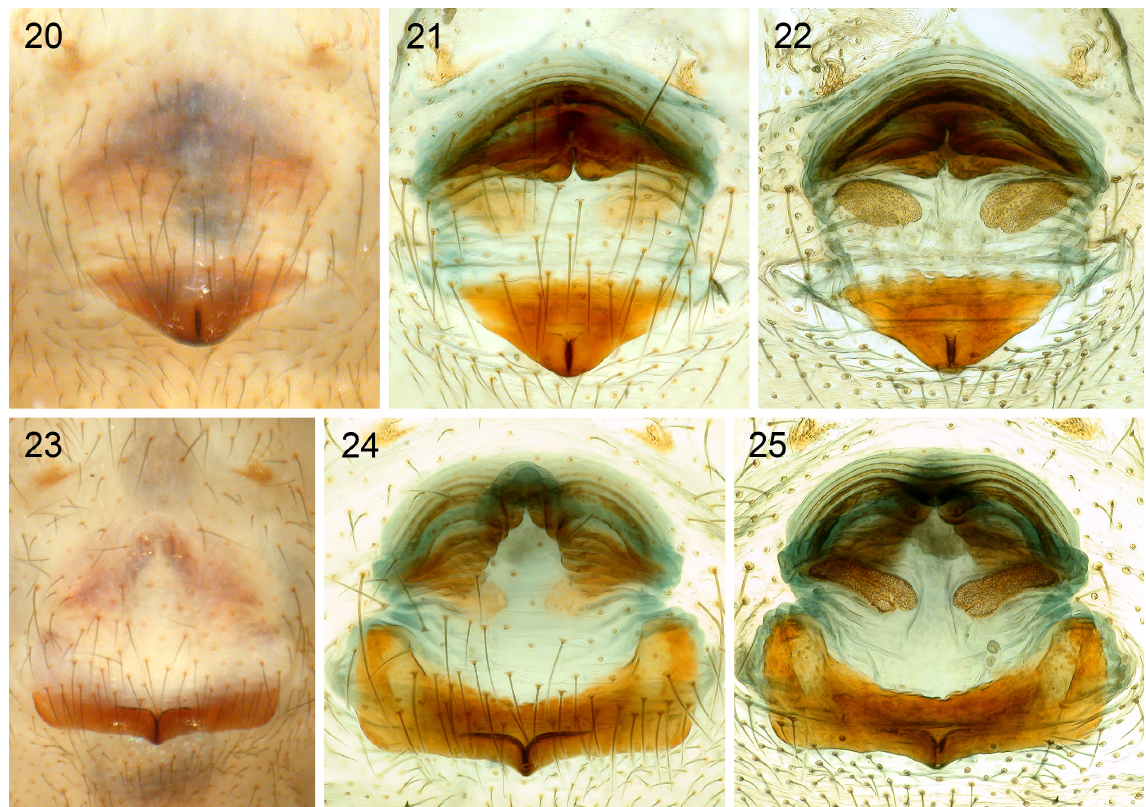
Figs 20–25. Aetana ocampoi Huber, sp. nov. Female genitalia of morph A (20–22) and morph B